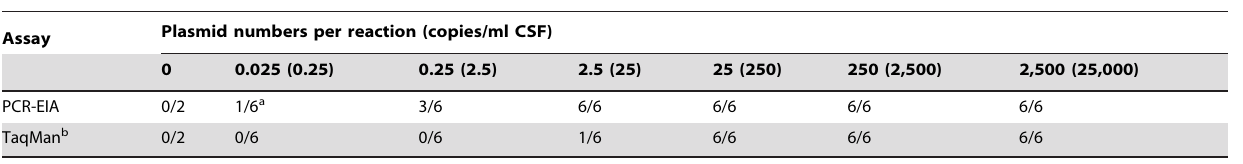
Table 4. Test sensitivity of C. pneumoniae DNA detection in plasmid-spiked CSF specimens.